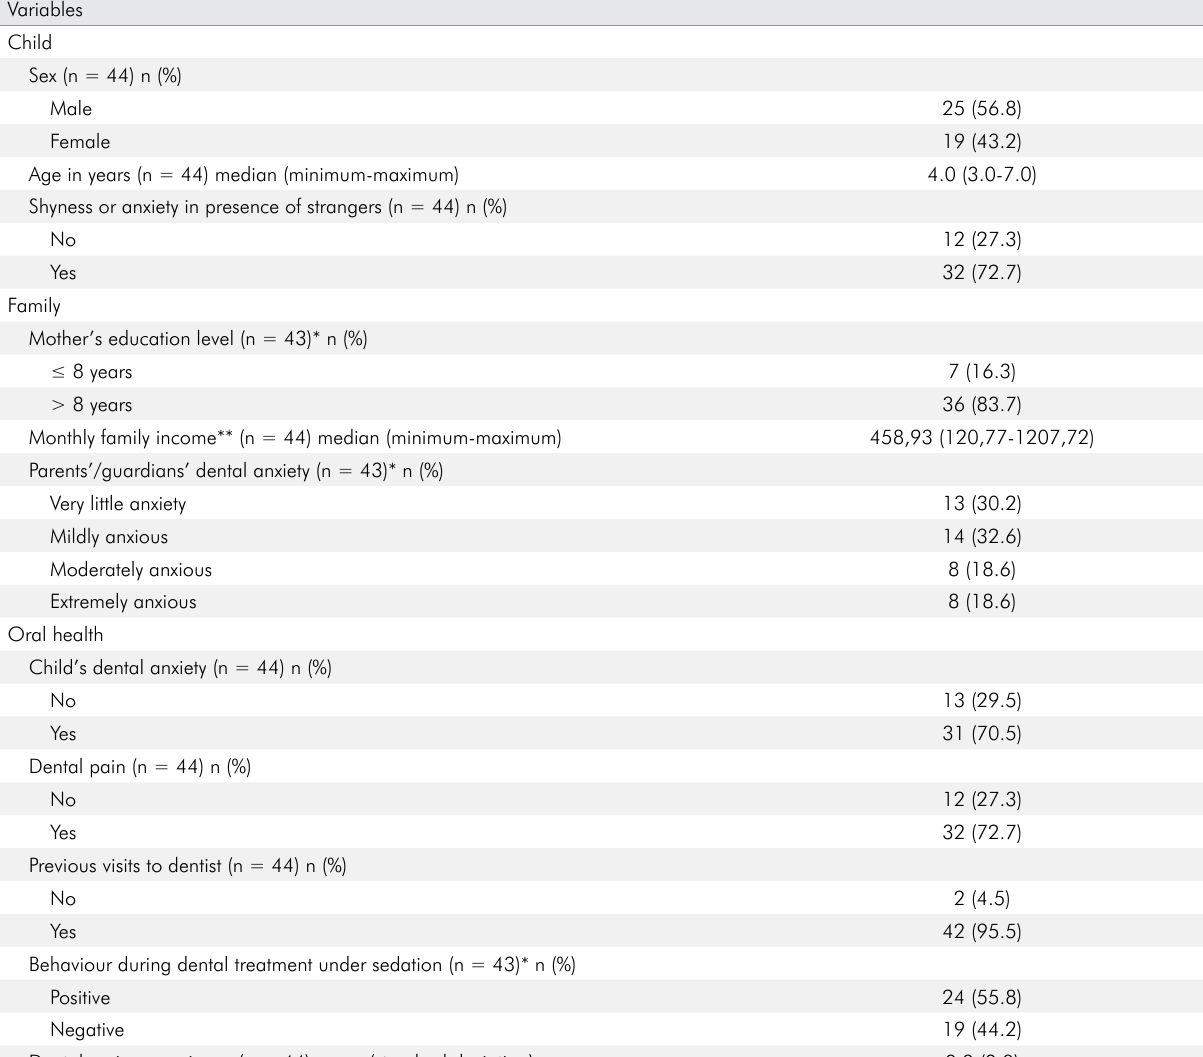
Table 1. Characteristics of participants (n =